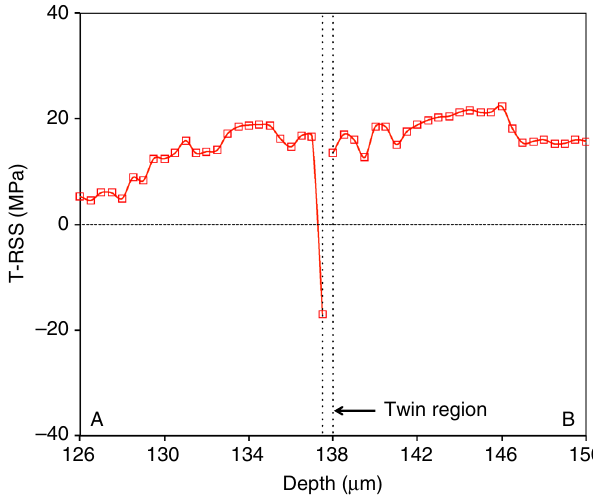
Fig 3 Twin-plane resolved shear stress distribution. Distribution of twin plane resolved shear stress with the step size of 0.5 μ m across tensile twin. The material point next to twin boundary on the left side only shows the stress reversal, and it may associated with twinning shear